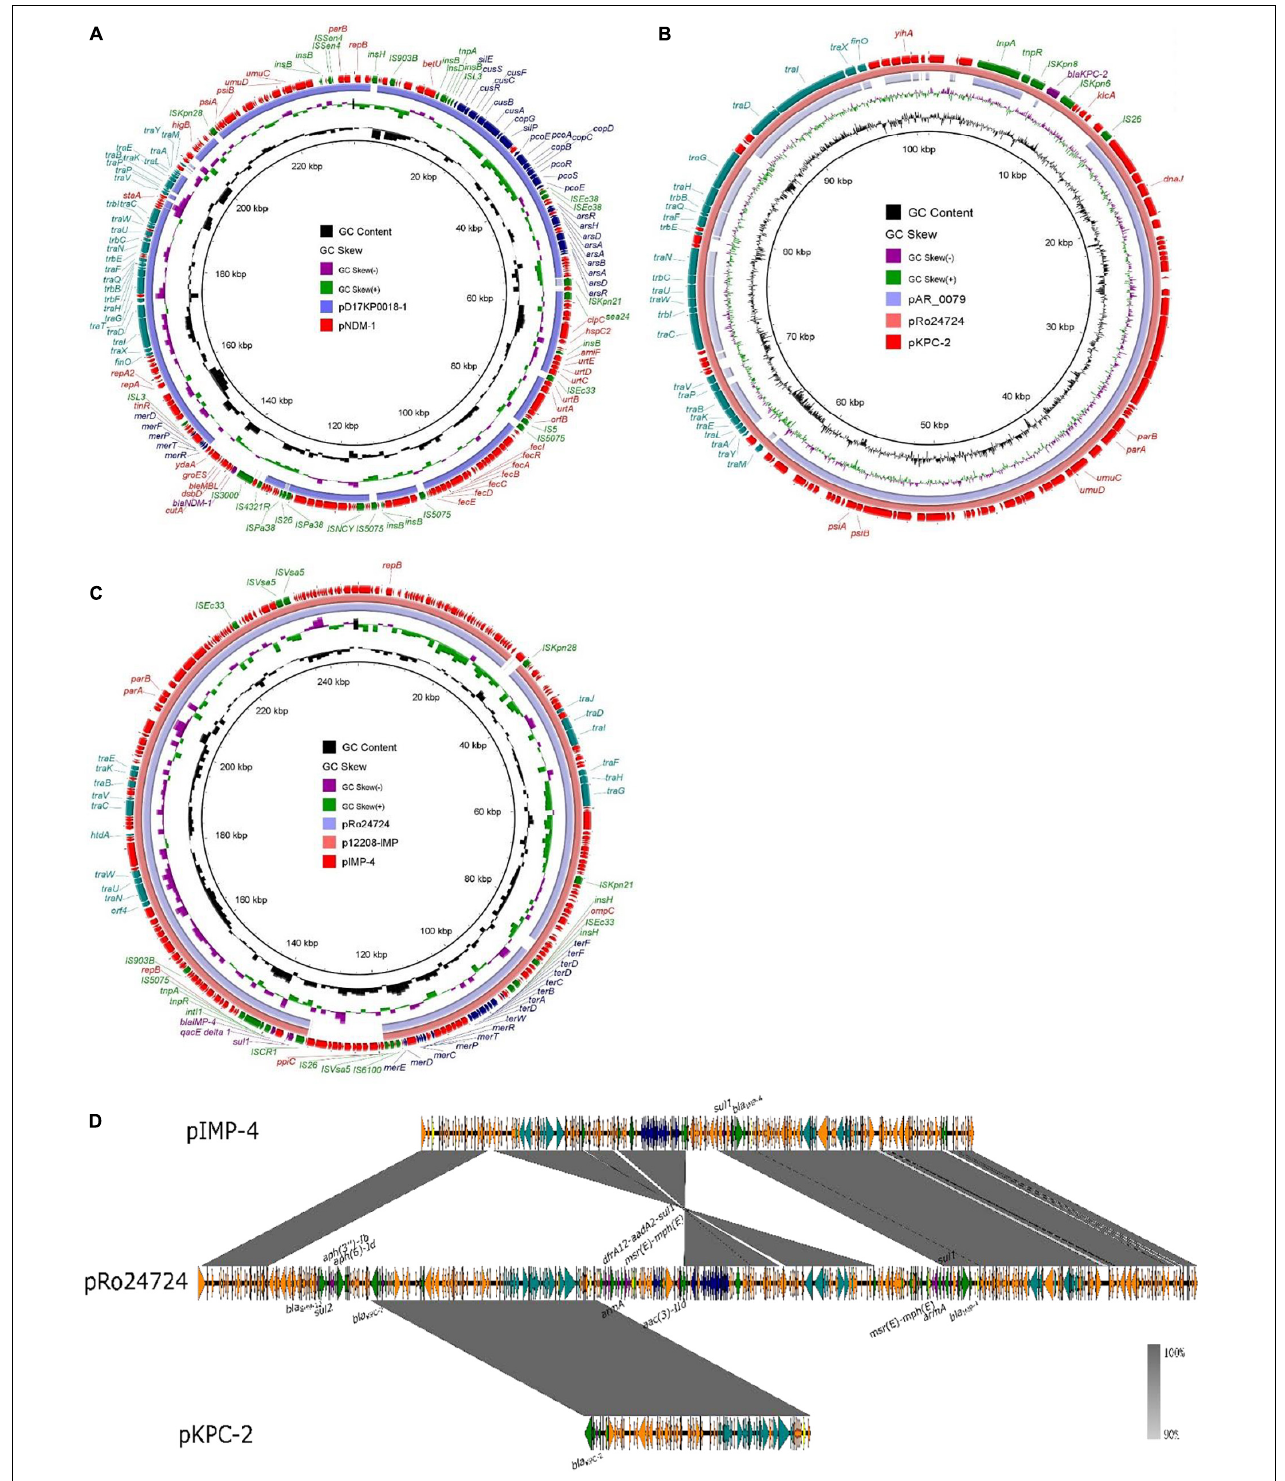
FIGURE 1 | Alignment of plasmid pK210011_NDM, pK210011_KPC and pK210011_IMP. (A) Plasmid pK210011_NDM showed highest similarity (88% coverage and 100% identity) to plasmid pD17KP0018-l (GenBank accession no. CP052337.1). (B) Plasmid p K210011_KPC showed highest similarity (100% coverage and 99.96% identity) to plasmid pRo24724 (GenBank accession no. CP021328.1) and plasmid pAR_0079 (GenBank accession no. CP029000.1, 84% coverage and 99.98% identity). (C) Plasmid pK210011_IMP showed highest similarity (93% coverage and 100% identity) to plasmid p12208-IMP (GenBank accession no. MF344562.1) and plasmid pRo24724 (92% coverage and 99.90% identity). (D) Alignment of plasmid pK210011_KPC, pK21001 l_IMP and pRo24724.